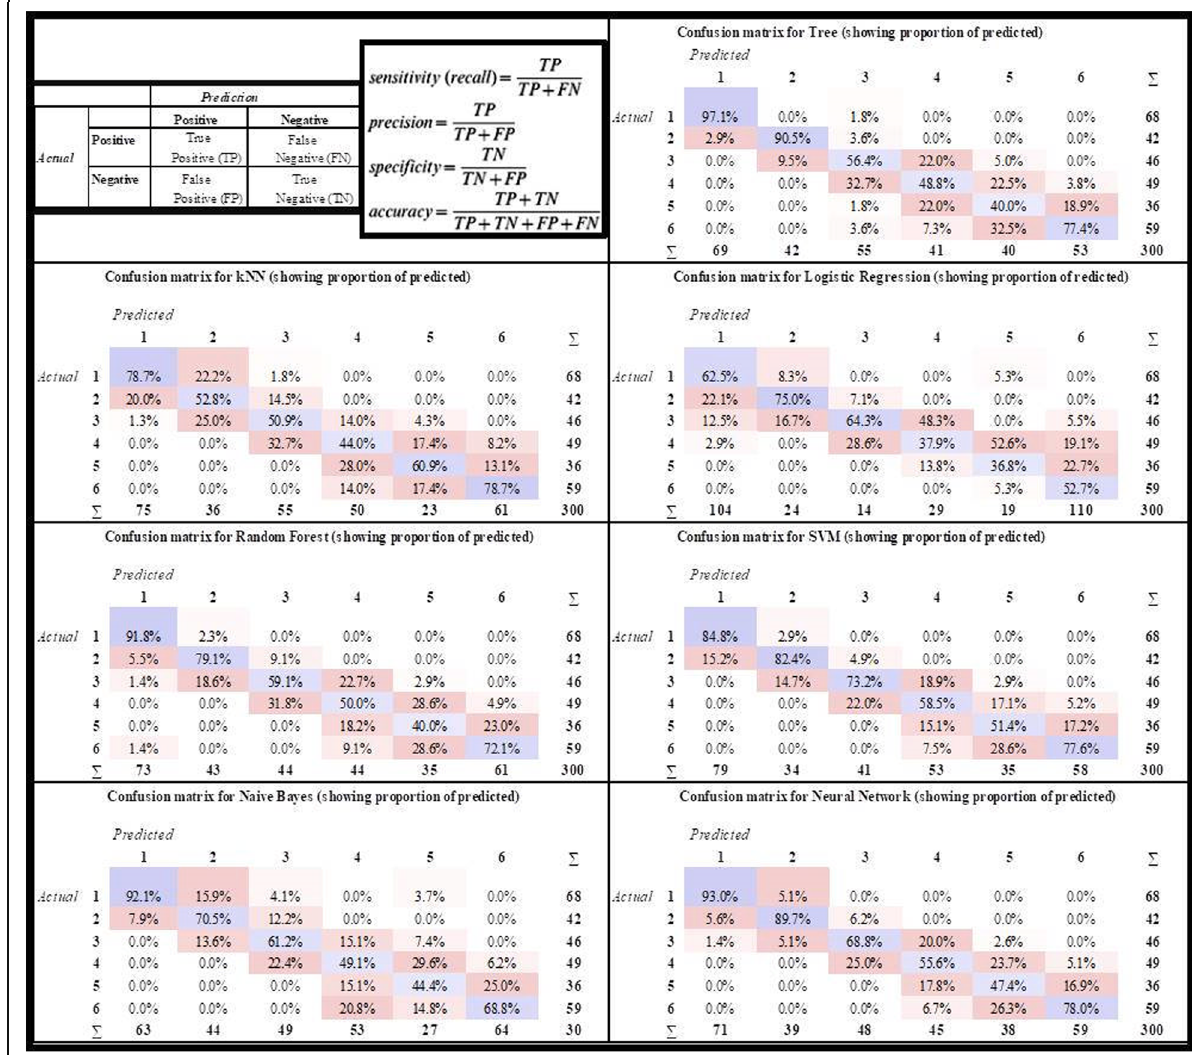
Fig. 2 The basic notations and the confusion matrices of the algorithms which were used for determination of